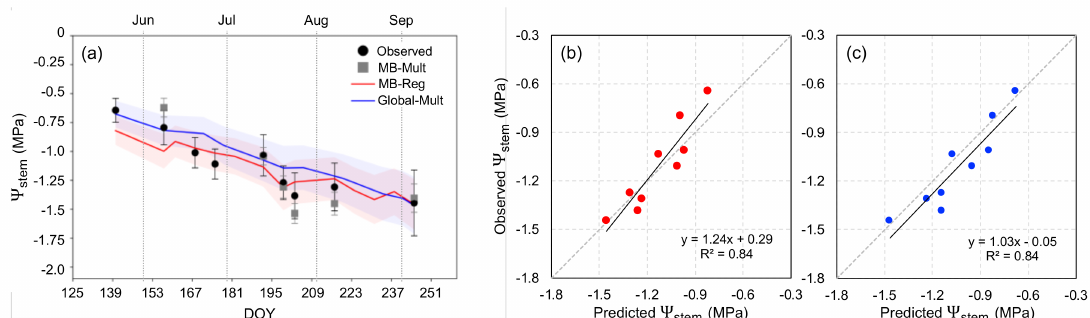
Figure 10. ( a ) Observed and predicted Ψ stem at Mevo Beitar vineyard for the 2017 growing season. Predicted Ψ stem was derived using the site-specific per-week multivariable MB-Mult model, the site-specific MB-Reg model, and the Global-Mult model. Red and blue shaded bands in ( a ) indicate model uncertainties in MB-Reg and Global-Mult , respectively, while error bars in MB-Mult and observations denote ± 1 σ . Scatterplot of observed vs. predicted Ψ stem for ( b ) MB-Reg and ( c ) Global-Mult